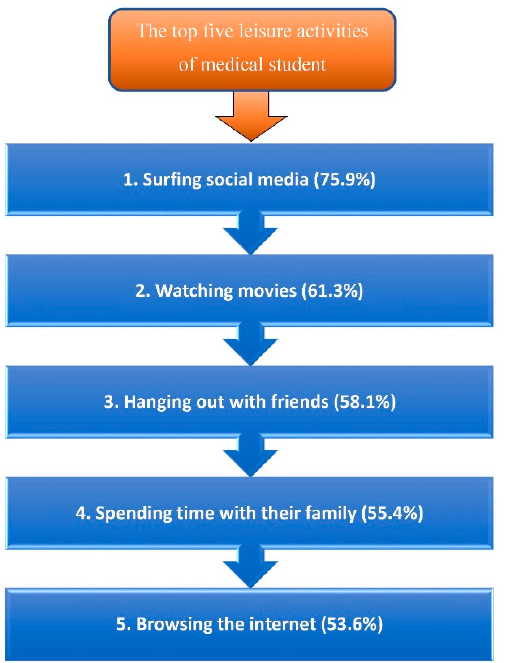
Figure 1. The top five leisure activities of medical